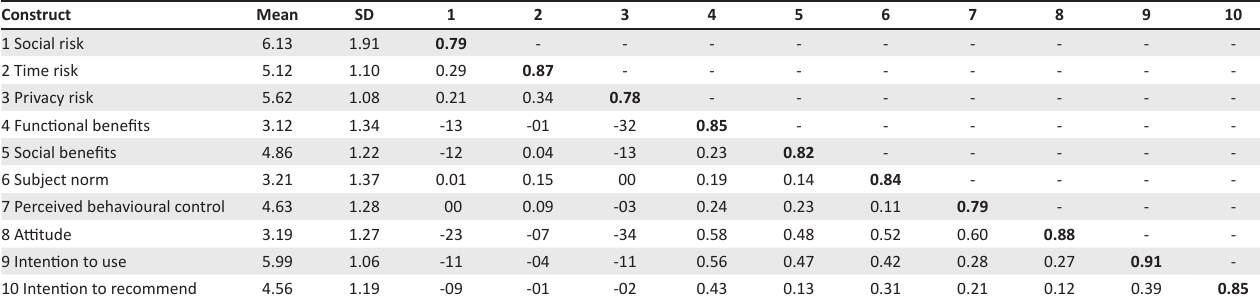
TABLE 3: Descriptive statistics, correlations and square root of AVE.